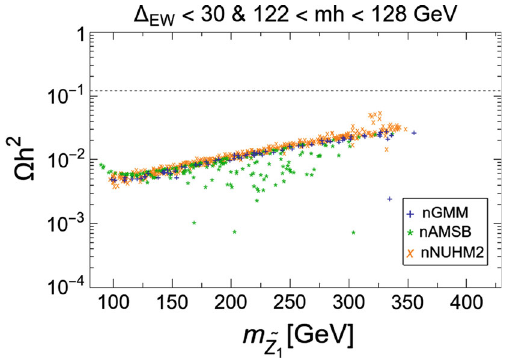
Fig. 1 Plot of points in the (cid:11) (cid:2) the natural NUHM2, nGMM and nAMSB model parameter space. The dashed line shows the measured